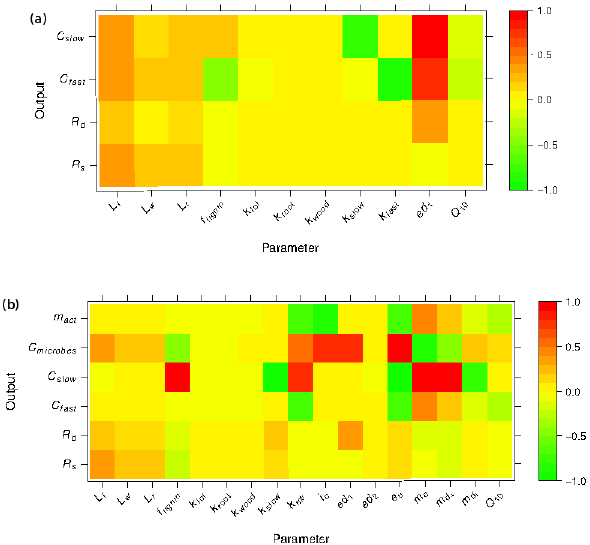
Figure 2. Sensitivity of the two models to their respective pa- rameters. Outputs tested were all three soil carbon pools includ- ing C fast and C slow for (a) the chemical model and fast ( C fast , gCm − 2 ), slow ( C slow , gCm − 2 ) and microbial pool ( C microbes , gCm − 2 ) for (b) the biological model. Also the sensitivity of three respiration fluxes were tested including total soil respiration ( R s , gCm − 2 d − 1 ), litter respiration ( R l , gCm − 2 d − 1 ) and respiration from soil decomposition ( R d , gCm − 2 d − 1 ) for both models. Model sensitivity was calculated using the method by Xenakis et al. (2008). Values close to or greater than − 1 and 1 show high negative and positive sensitivity respectively. For all symbol explanations, see Table 1.